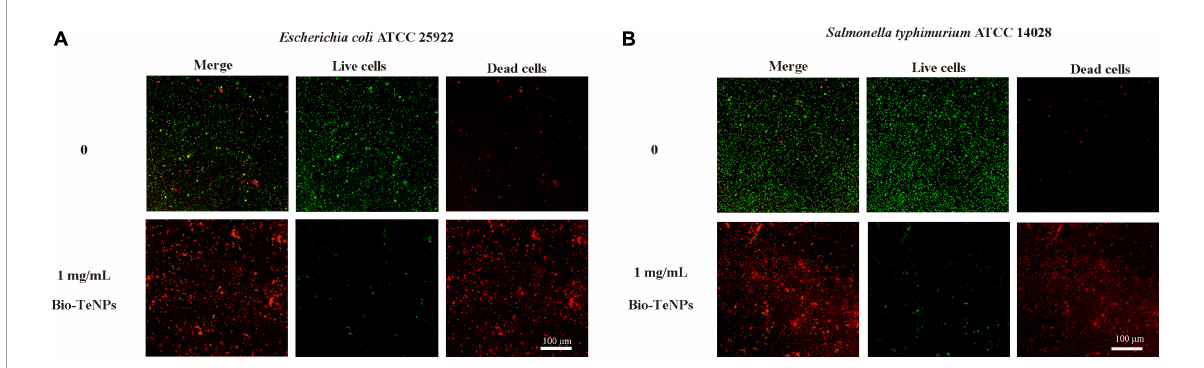
FIGURE7 Live/dead cells analyzed by LSCM. (A) Fluorescence images of E . coli with or without 1 mg/mL Bio-TeNPs for 4 h. (B) Fluorescence images of S . typhimurium with or without 1 mg/mL Bio-TeNPs for 4 h. Most of the cells died after 4 h of treatment with Bio-TeNPs. Live/dead staining is shown as green for live cells and red for dead cells.